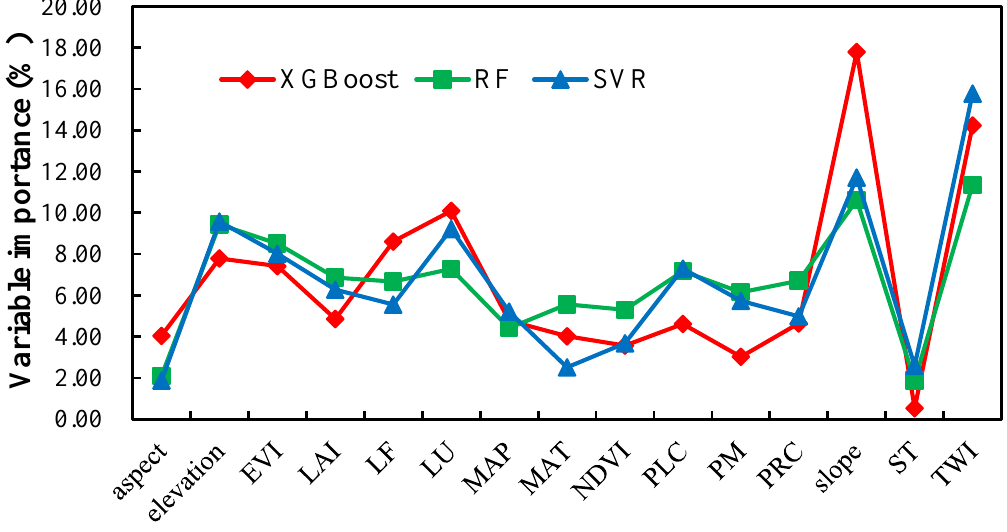
Figure 7. The importance of environmental variables from random forest models.